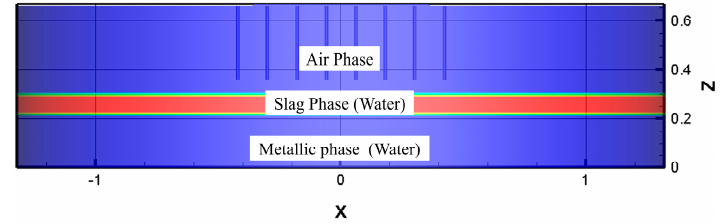
Figure 1. Furnace design.